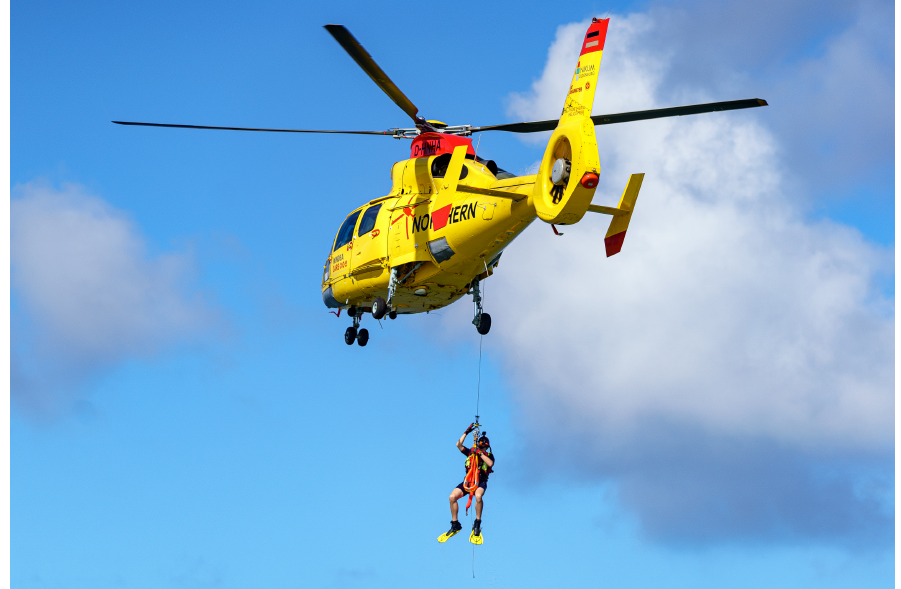
Figure 4. Testing the Openmax approach with a very different image in comparison with the other open set images in MSTAR radar